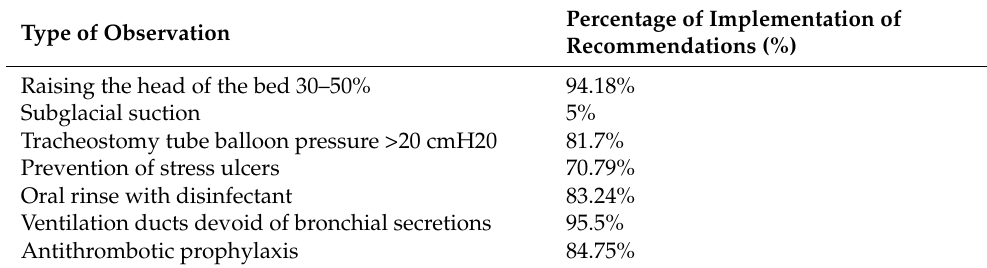
Table 5. Assessment of the implementation of preventive packages for VAP ( n = 236 observations). Results are presented as % of follow-up of recommendations from the total number of